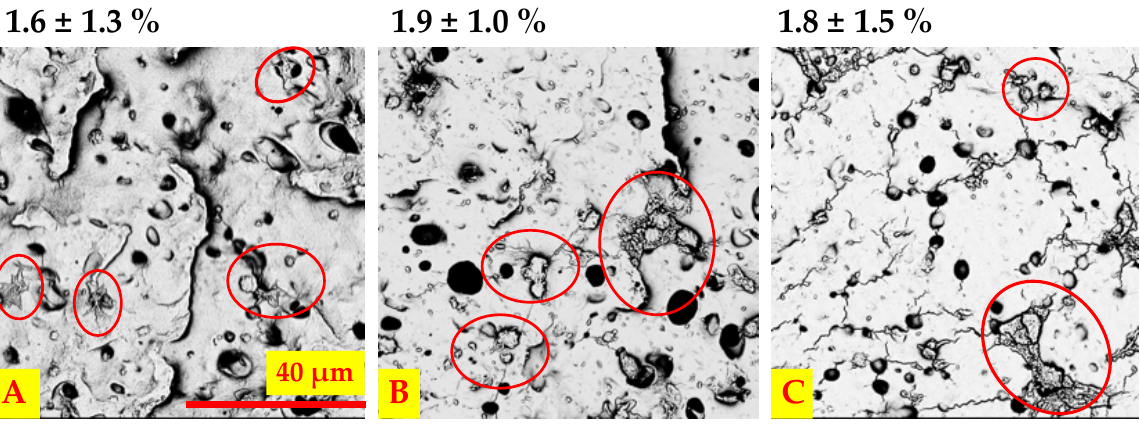
Figure 10. SEM images of analyzed materials’ surface after contact with blood, ( A ) unmodified PU, ( B ) PU_REDV, ad ( C ) PU_YIGSR, scale bar 40 μm; the percentage of the platelet-coated area is given above each image.